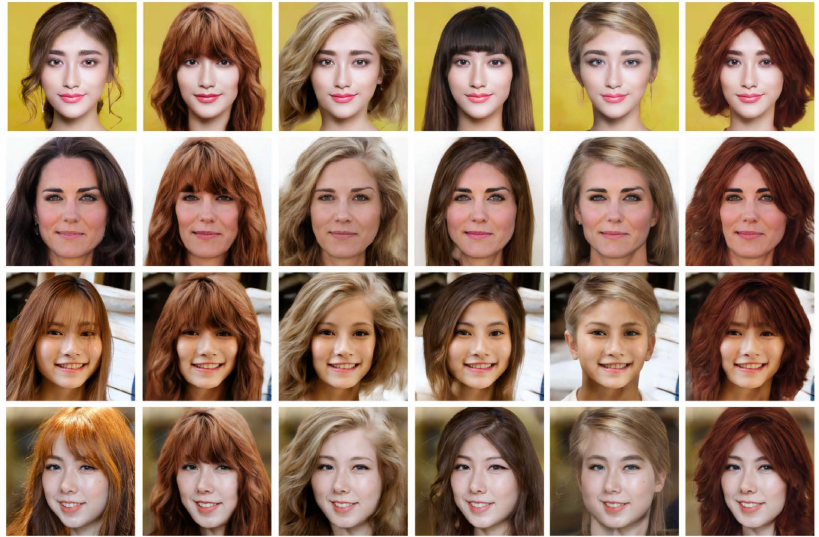
Figure 8. Comparison of different new hairstyles for women.